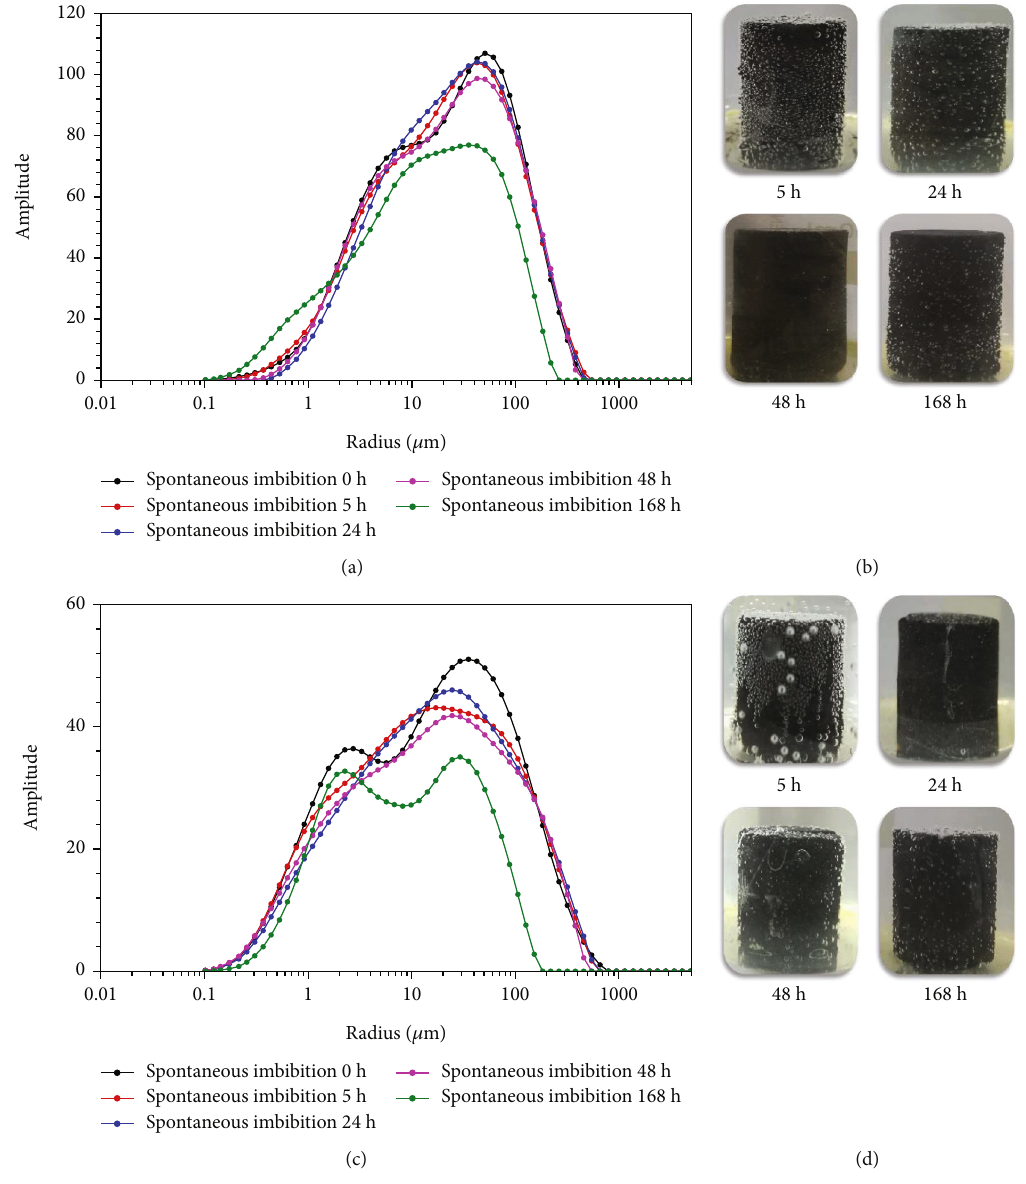
Figure 3: Nuclear magnetic resonance T spectrum curves and photos of core 3-1/3-2. (a) Curves of core 3-1; (b) photos of core 3-1; (c) 2 curves of 3-2; (d) photos of core